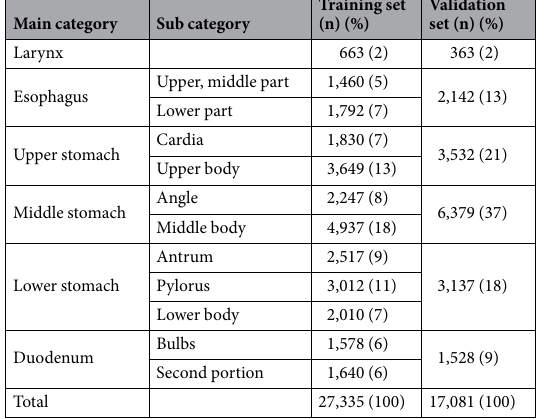
Table 4. Anatomical classification of the training image set and validation image